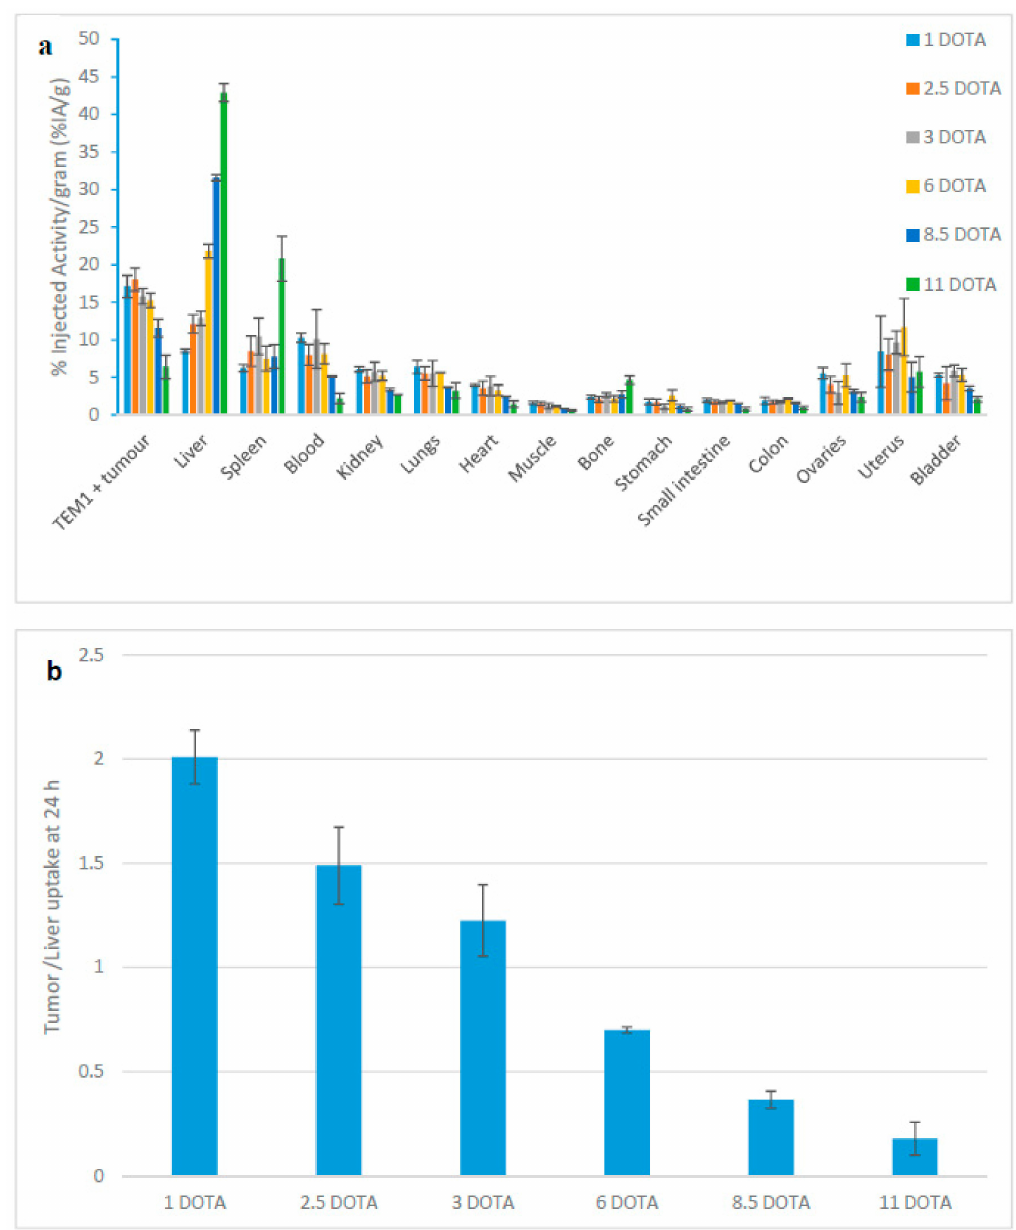
Figure 1. ( a ) Biodistribution at 24 h of [ 177 Lu]Lu-1C1m-Fc conjugated with 1 to 11 DOTA in Balb/c nu mice bearing TEM-1 positive tumor. Data are shown as mean ± SD. ( b ) Ratio between the tumor and the liver uptake at 24 h with respect to the number of DOTA per [ 177 Lu]Lu-1C1m-Fc in Balb/c mice bearing TEM-1 positive tumor. Spearman test gives a rho = − 0.99, p <